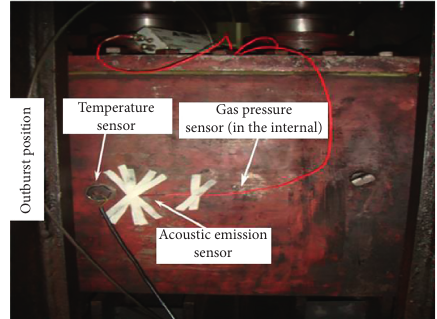
Figure 2: Layout of AE and temperature